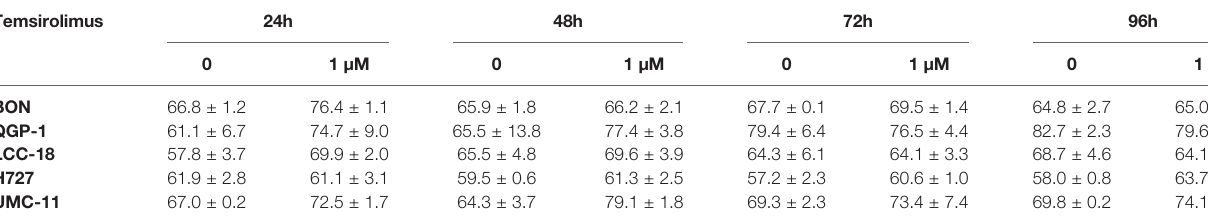
TABLE 2 | Percentages of cells in G1 cell cycle after mTOR inhibitor treatment. Temsirolimus